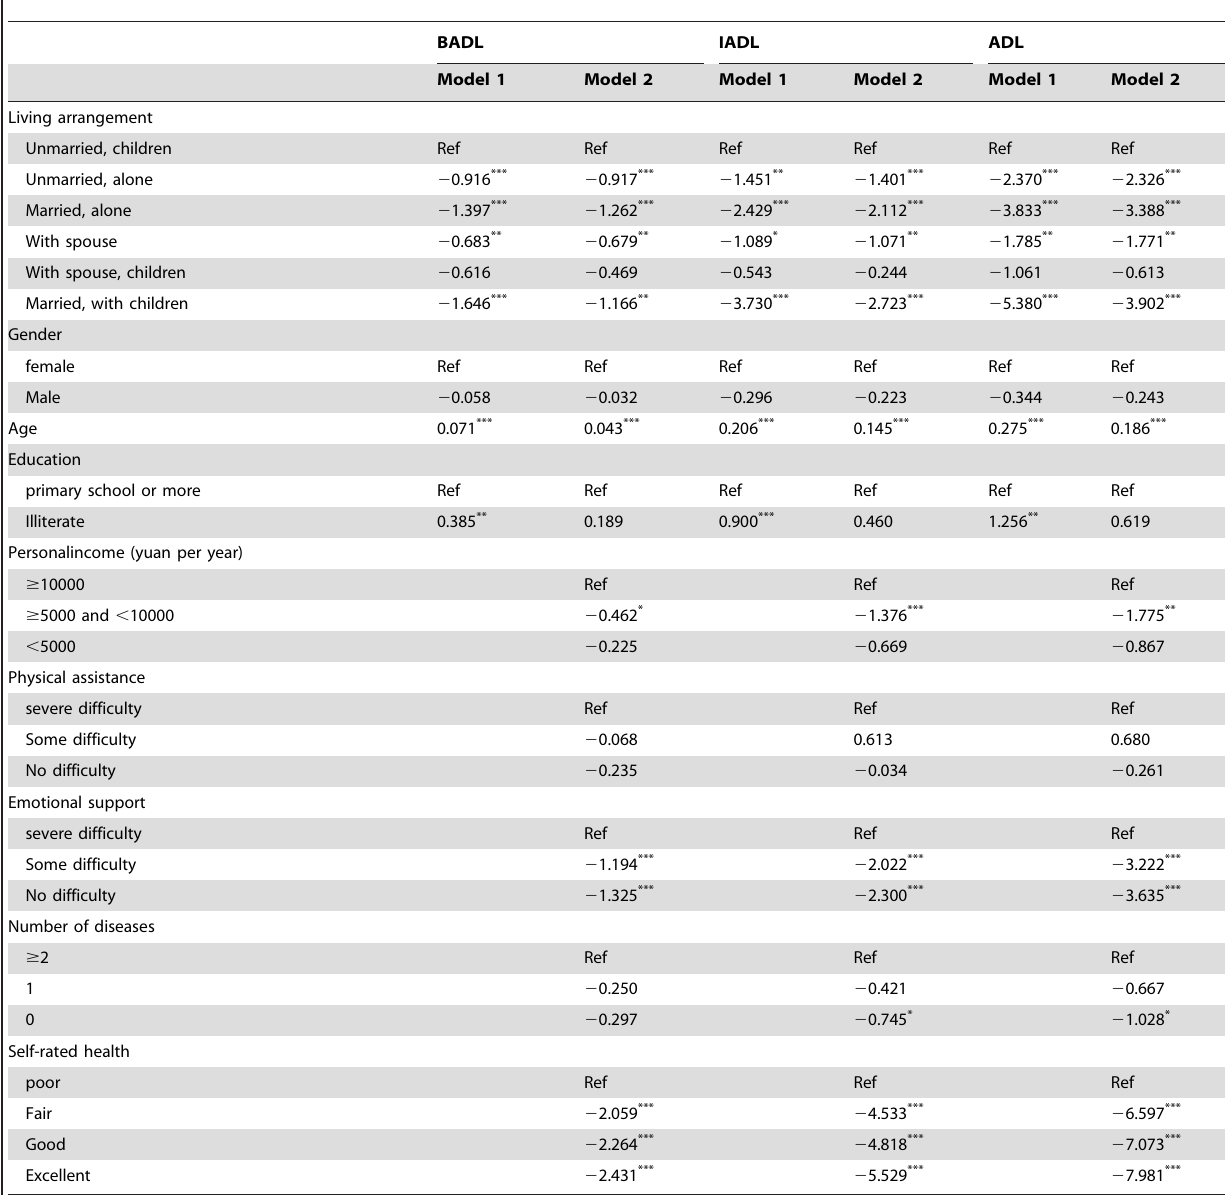
Table 3. Coefficients from multiple linear regression analyses of functional disability by living